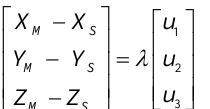
where  is the normalized form of vector Ru in Eq.(3). Eq.(6) can be further written as